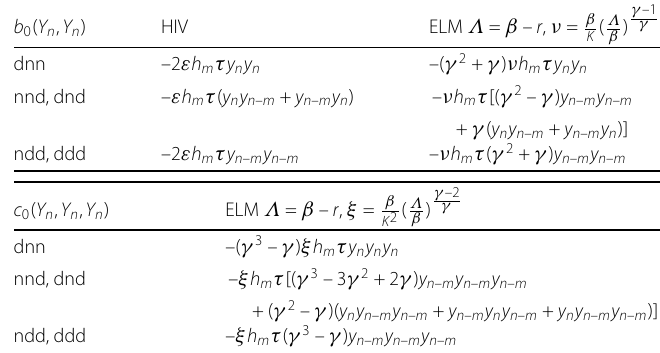
Table 6 Table of b 0 ( Y n , Y n ) and c 0 ( Y n , Y n , Y n ) formulas for HIV and ELM